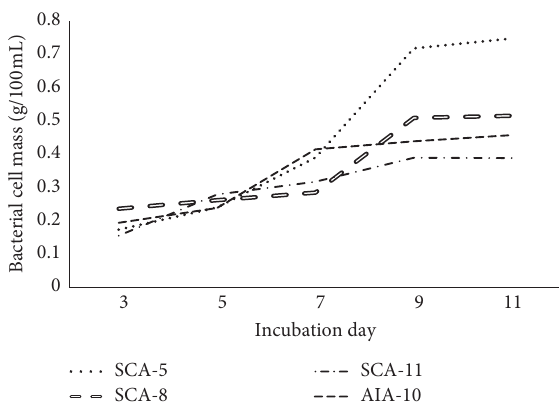
Figure 5: Growth curve of selected Streptomyces isolates on ISP-2 broth based on incubation times; mycelial pellets were harvested for growth determination by biomass measurement. Table 5: Inhibition zone (mm) of the metabolite-crude-extract (10mg/mL) by the disc-diffusion method. extract